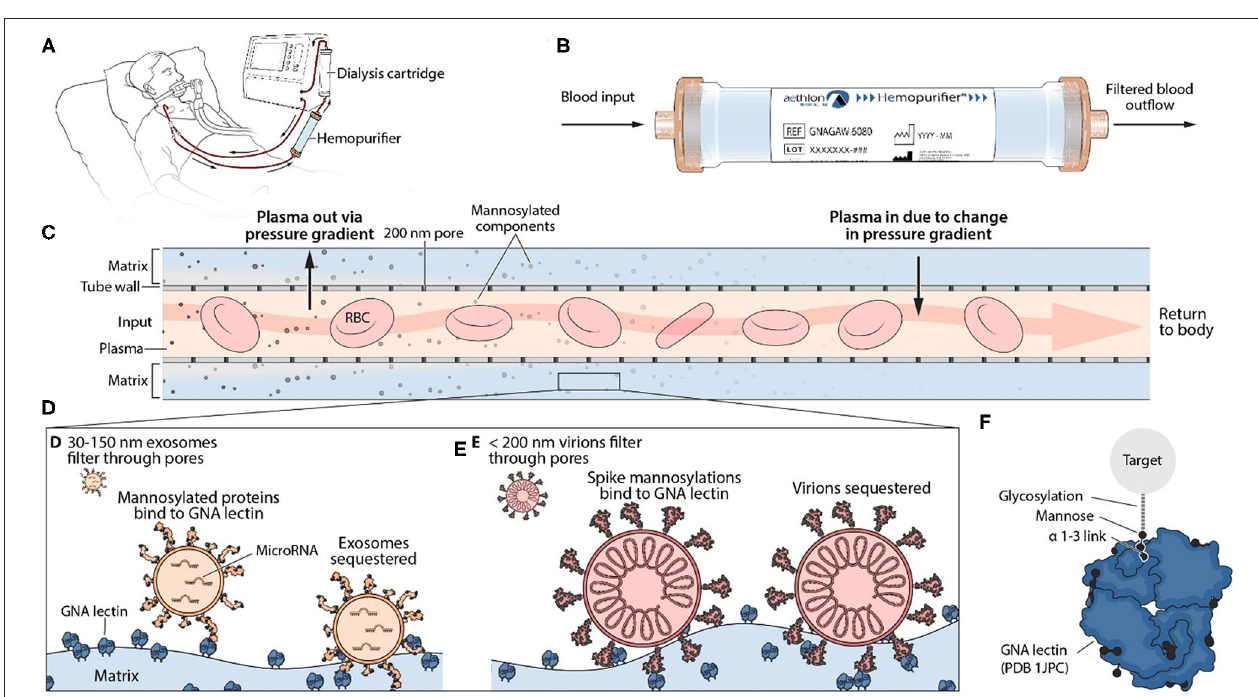
FIGURE 2 | Mechanism of Action of Hemopurifier Lectin-Affinity Cartridge. (A) Set-up of Hemopurifier. (B) Blood flow through Hemopurifier. (C) Plasma separation and size exclusion within the Hemopurifier. (D) Binding of mannosylated exosomes to the GNA lectin. (E) Binding of mannosylated virions to GNA lectin. (F) GNA lectin binding to high mannose glycans with alpha 1-3 linkage.